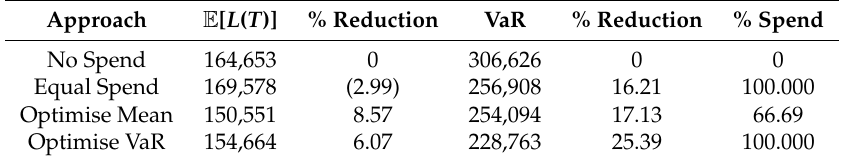
Table 6. The Average, VaR and % Spend of Budget for the four densities in Figure 7. The % reductions are from the “No Spend” case, the term in parenthesis represents an increase. The VaR terms are simulated, their errors going down are 0.9%, 0.6%, 0.8% and 0.6% respectively. Note that these values are inclusive of the budget spent, so in the bottom row the average amount of damages over the period